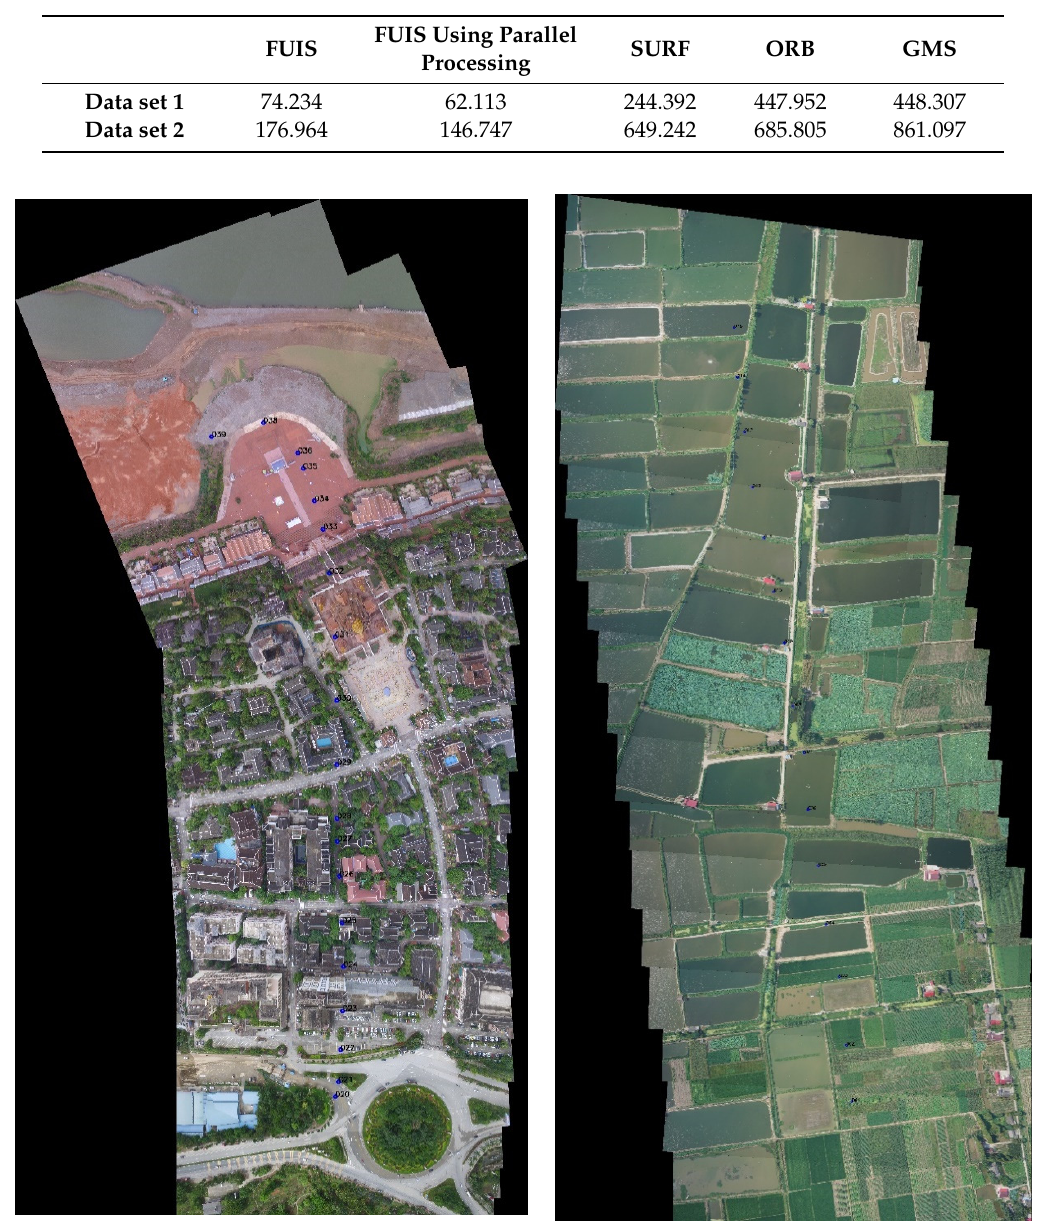
Figure 4. Stitching result of image sequences (the left one is the result of data set 1. The right one is data set 2.).